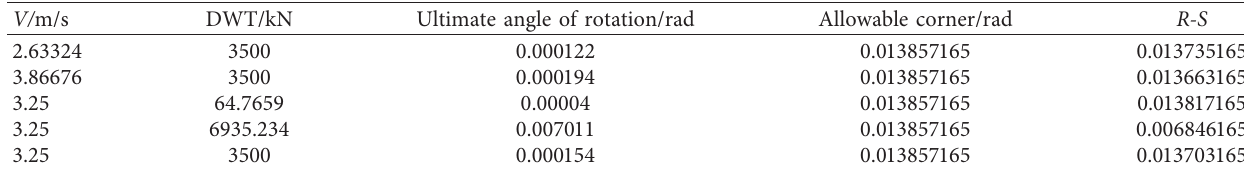
Figure 6: Curve of variation of pile base allowable turning angle. Table 6: Iteration 1 (at build-out).